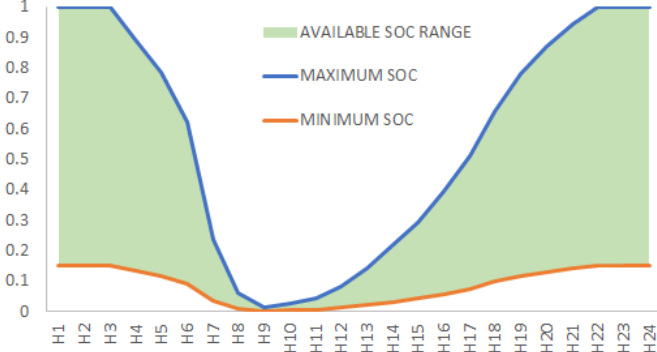
Figure 3. Illustration of the available state of charge (SOC) range of electric vehicles during the